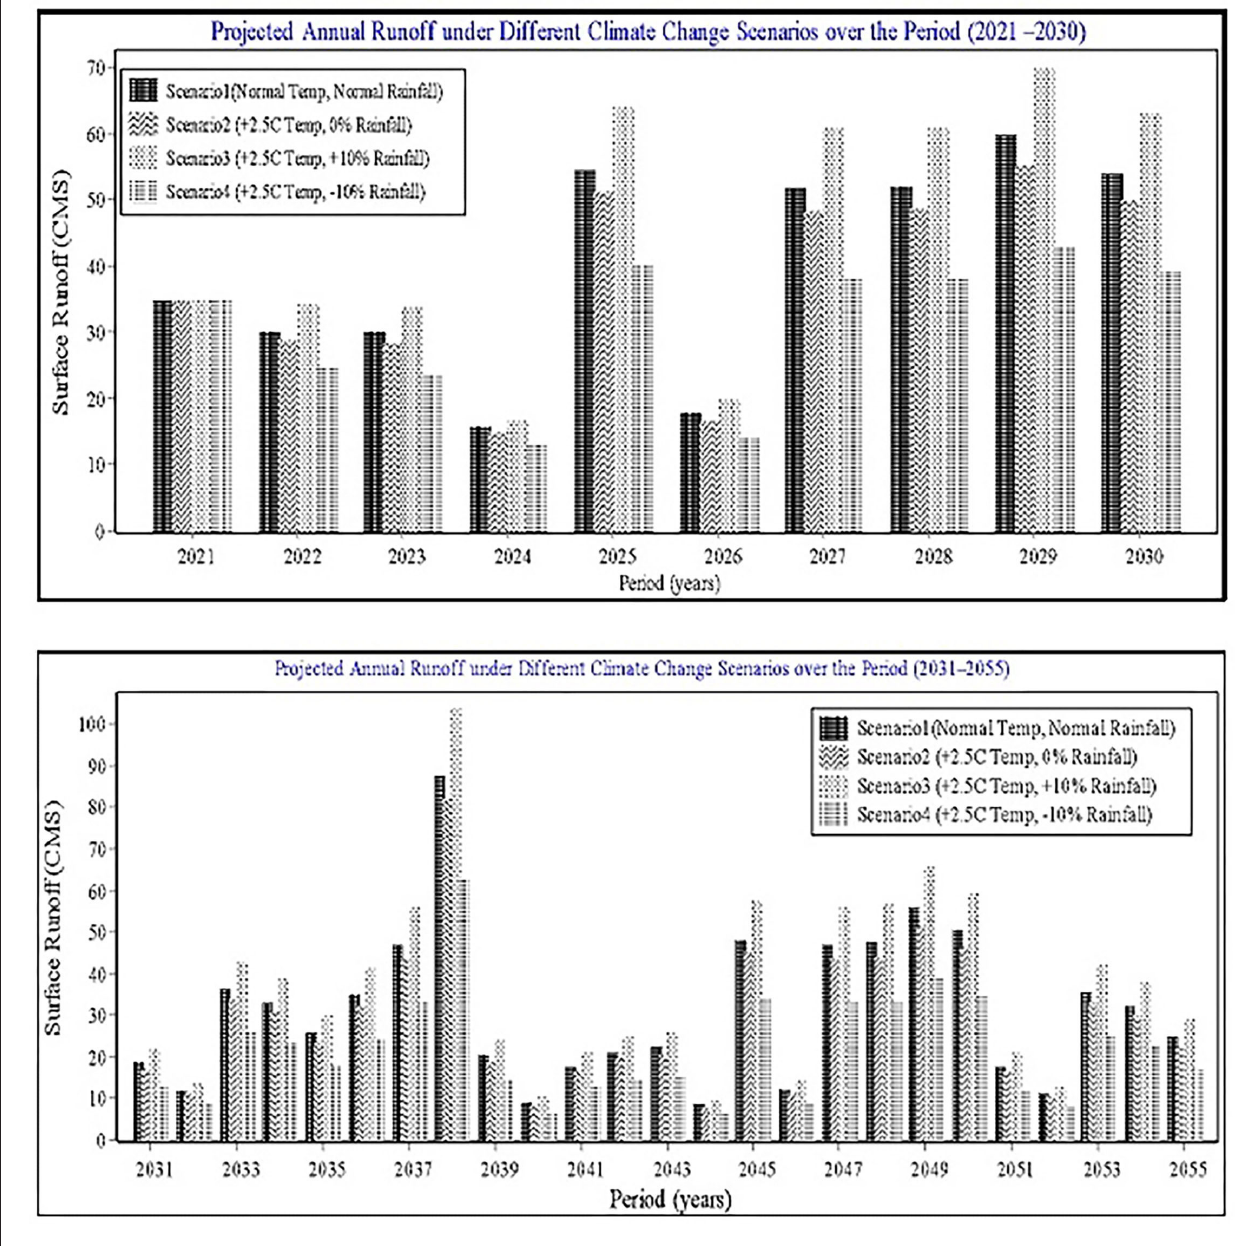
FIGURE 8 | Projected monthly synthetic scenarios over the period